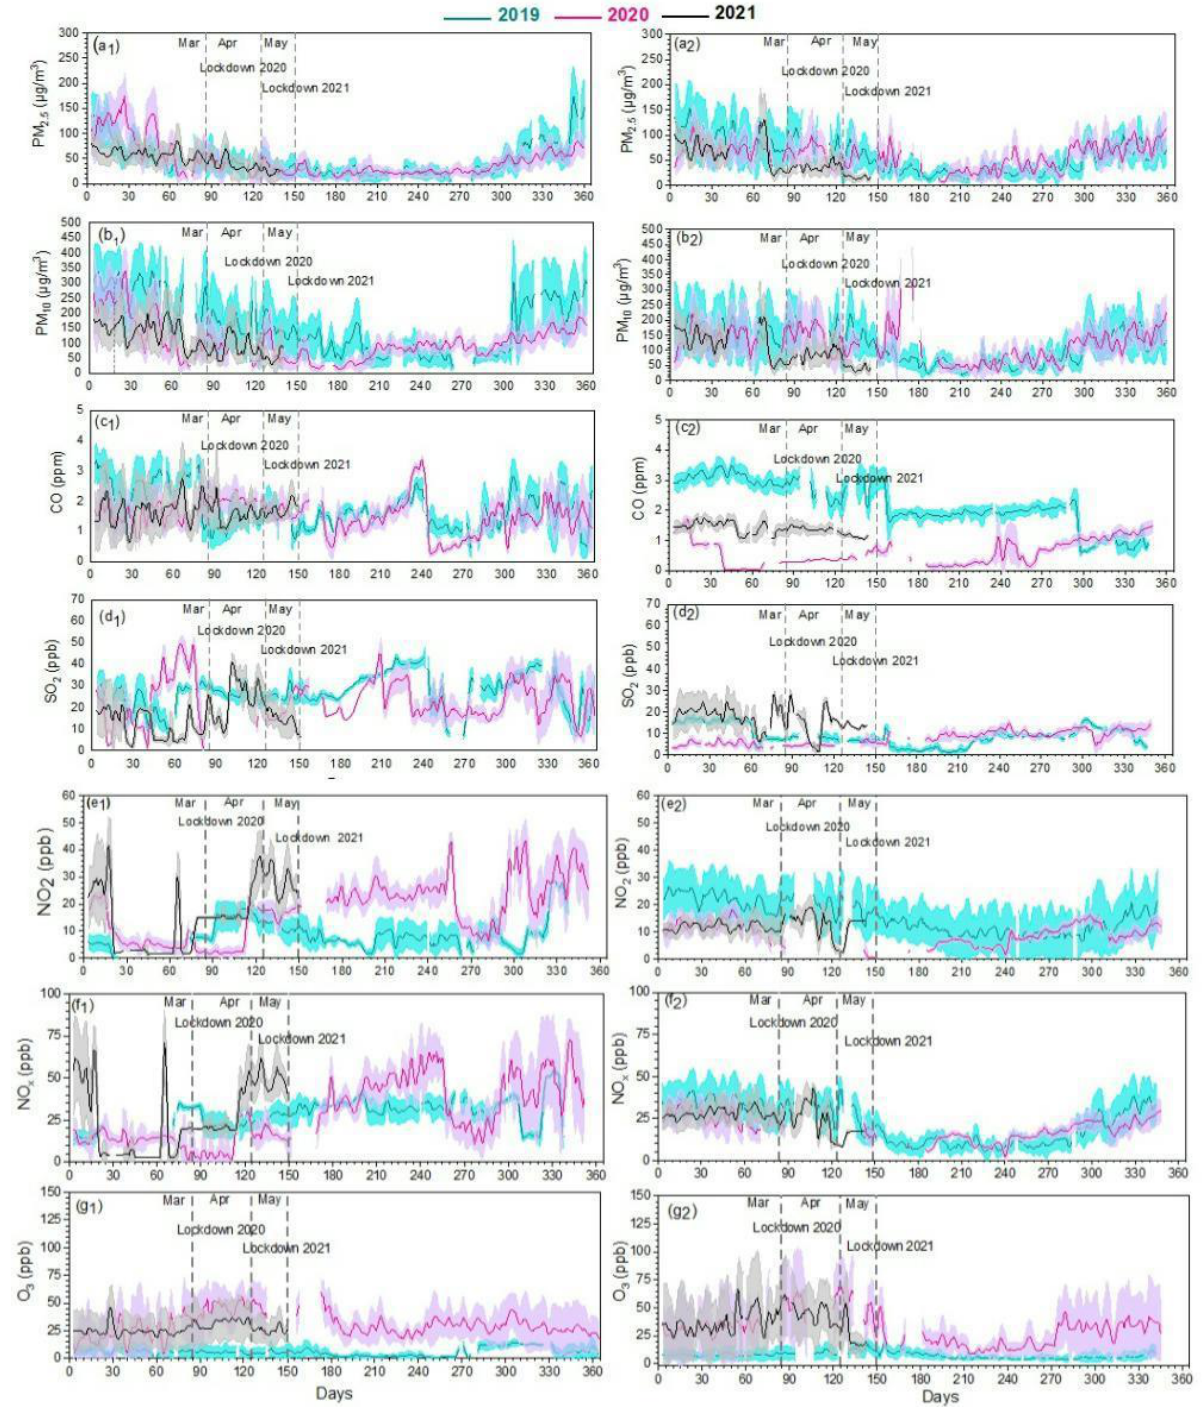
Figure 2. Trends in hourly averages of PM 2.5 , PM 10 , CO, SO 2 , NO 2 , NO x , and O 3 concentrations between 2019 – 2021 (dotted 1st vertical line shows pre-LD period; 1st and 2nd vertical dotted line section shows LD2020; and 2nd and 3rd line section shows LD2021) for site #1 ( a 1 – g 1 ) and site #2 ( a 2 – g 2 ).